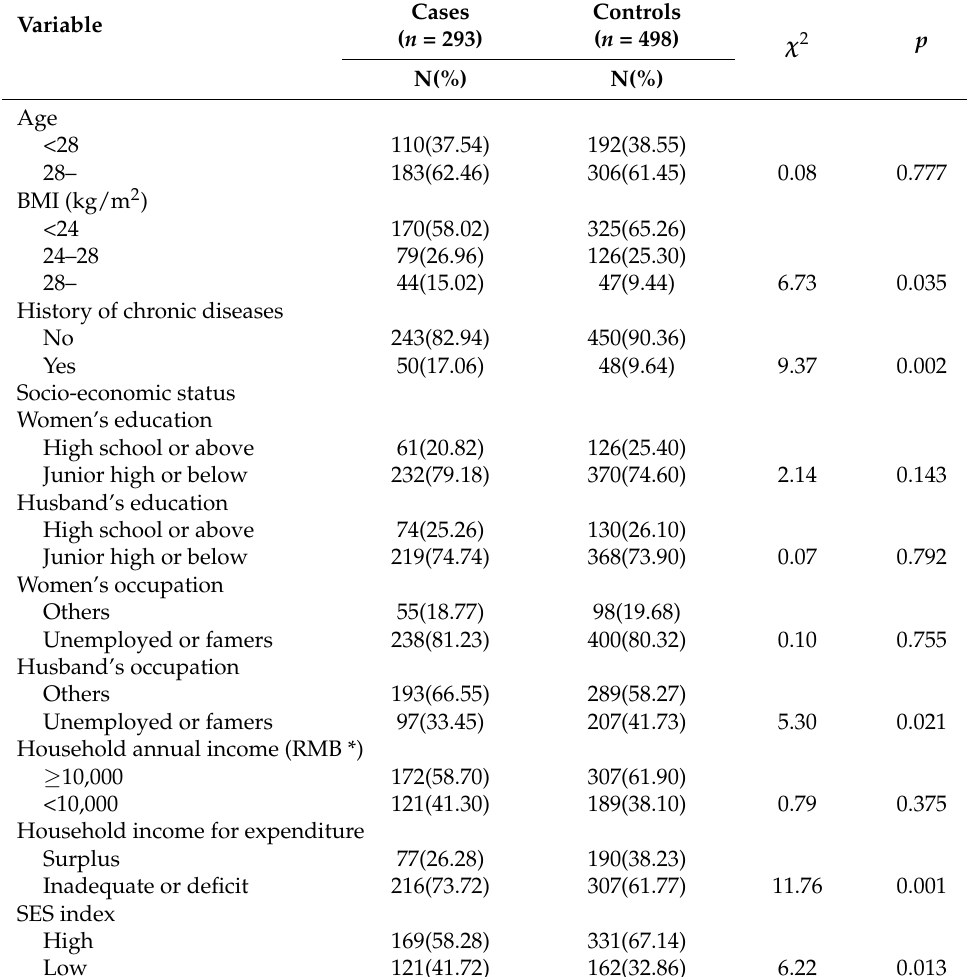
Table 1. Demographic, socio-economic, nutritional, behavioral and vitamin D status differences between spontaneous abortion cases and